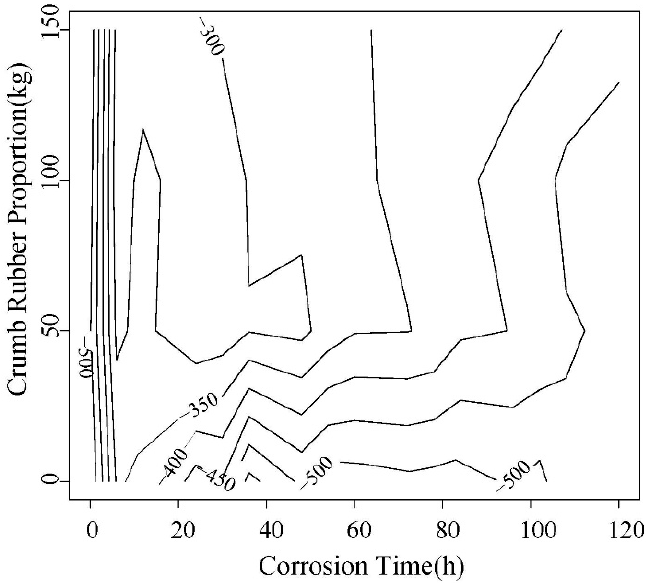
Figure 7. Change trend of corrosion potential of steel bar in 0.55 water-cement ratio.